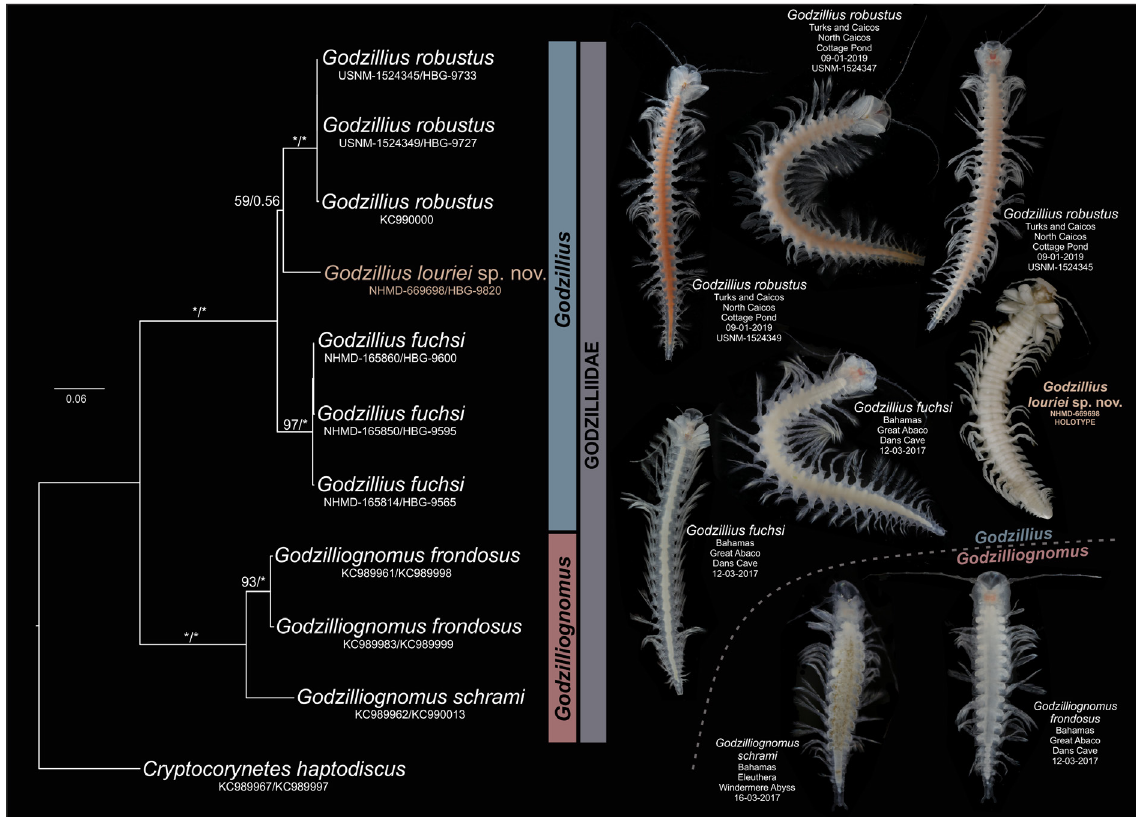
Fig. 11. Maximum likelihood analyses and Bayesian Inference of concatenated gene data (16S rRNA and H3) for Godzilliidae. Bootstrap support values and posterior probabilities provided above branches (ML/BI). Any bootstrap value or posterior probability at 100 or 1.0, respectively, is indicated with an asterisk (*). For the concatenated gene analyses, different individuals identified (not this study) as the same species were concatenated together using GenBank sequence data: KC989961 + KC989998, KC989983 + KC989999 and KC989962 + KC990013. Photos of species of Godzilliidae by Jørgen Olesen. All except Godzillius louriei sp. nov. are of live specimens. Photos are not to the same